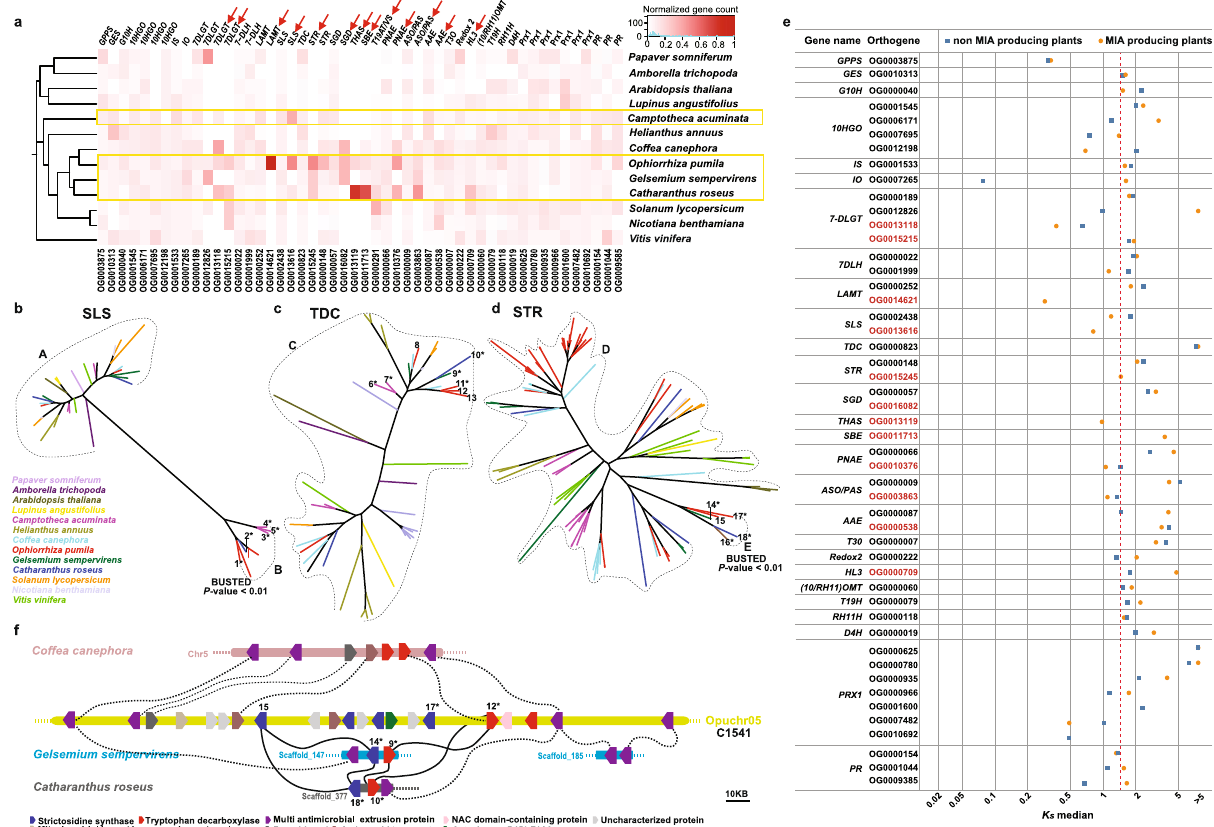
Fig. 6 Emergence of strictosidine synthase, the starting point for the evolution of monoterpene indole alkaloid biosynthesis in plants. a Normalized gene count data for orthogene families assigned to MIA biosynthesis across 13 plant species. The yellow box indicates MIA-producing plants. Normalization was performed by dividing gene count data for a speci fi c plant species with total number of genes assigned to a given orthogene family. The red arrows at the top of gene names highlight the orthogene families speci fi cally gained or expanded in the MIA-producing plant species. b – d Maximum likelihood phylogenetic tree based on genes from orthogene OG0002438 (A) and OG0013616 (B) , representing SLS ; orthogene OG0000823 (C) , representing TDC ; and orthogene OG0000148 (D) and OG0015245 (E) , representing STR coding genes. BUSTED analysis was performed using genes in the group B as test set and the genes in the group A as the background for SLS, and genes in the group E as test set against genes in the group D as the background for STR. *Functionally characterized genes. 1: Opuchr02_g0013060-1.1; 2: CRO_T109448; 3: Cac_g017137.t1; 4: Cac_g012666.t1; 5: Cac_g012664.t1; 6: Cac_g023139.t1; 7: Cac_g018974.t1; 8: Opuchr05_g0005520-1.1; 9: Gs_TDC; 10: CRO_T125328; 11: Opu_chr01_g0011270-1.1; 12: CRO_T125329. e Median synonymous substitutions per synonymous sites (Ks) distribution for genes associated with secoiridoid and MIA biosynthesis pathways across MIA-producing and non-MIA-producing plants. Dotted red line refers to Ks median for functional STR in Ophiorrhiza genome. Orthogenes highlighted by red color are the orthogenes speci fi cally gained or expanded in MIA-producing plants as shown in a . f Conserved gene clusters, C1541, essential for the biosynthesis of strictosidine-derived MIAs. Dashed lines show syntenic blocks, while scaffolds for each genome are shown through